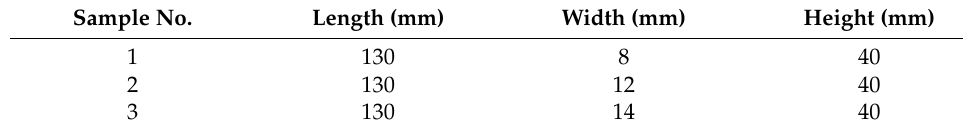
Table 3. Dimensions of the samples produced by CMT–WAAM deposition.